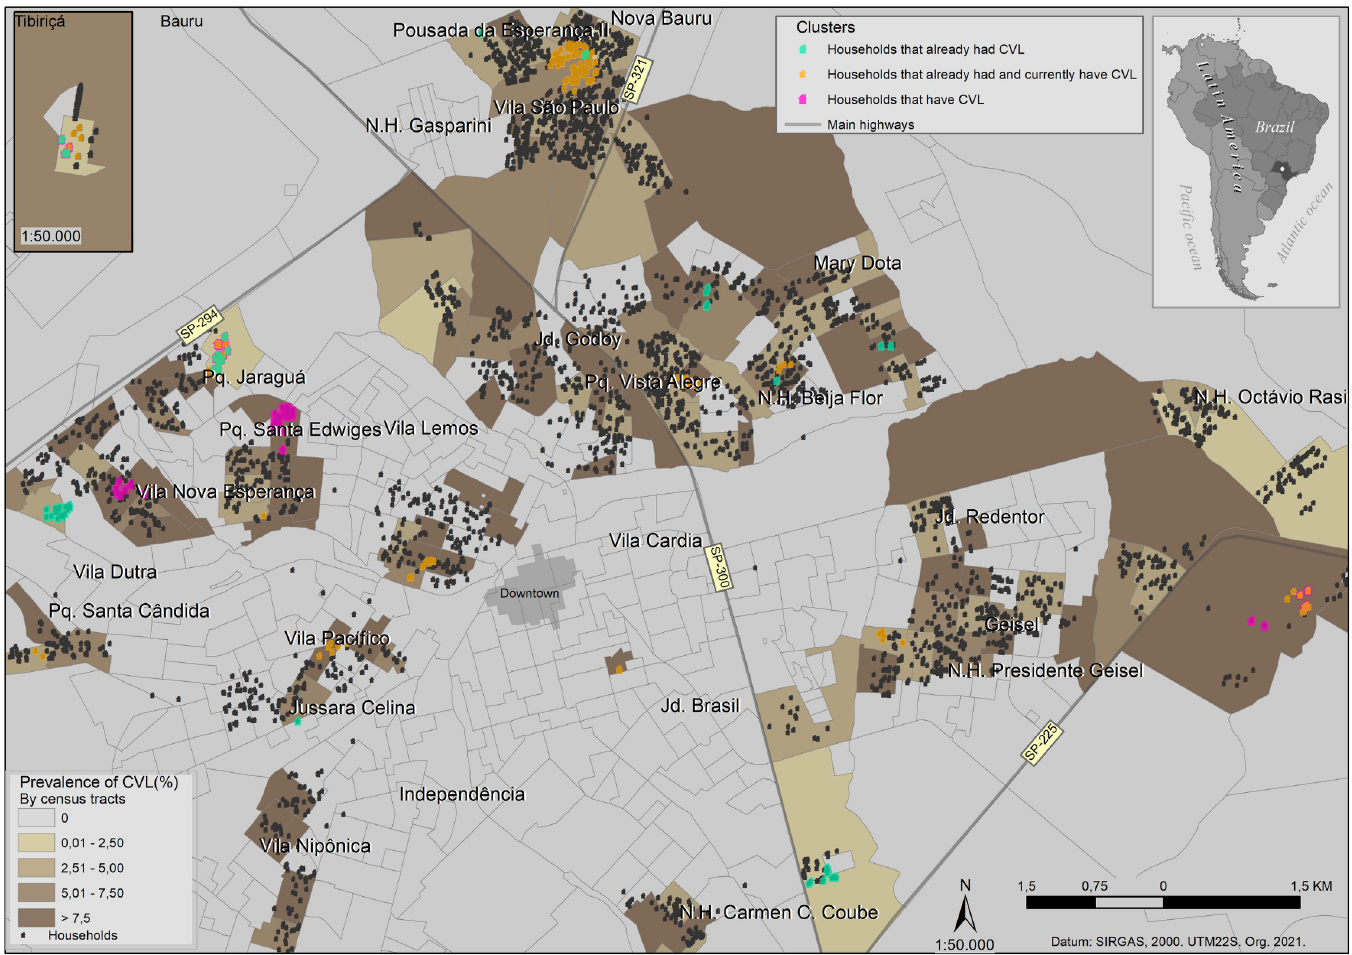
Fig 4. Geocoded households of Bauru, stratified by prevalence and cluster analysis. Each black dot is a household with no identified cluster. Magenta dots are the clusters of domiciles with infected dogs; green dots are the clusters of households that already had infected dogs; and orange dots represent the clusters of households that had and currently have infected dogs. Different size symbols and opacity households were set to ensure the spatial visualization of overlapped households.